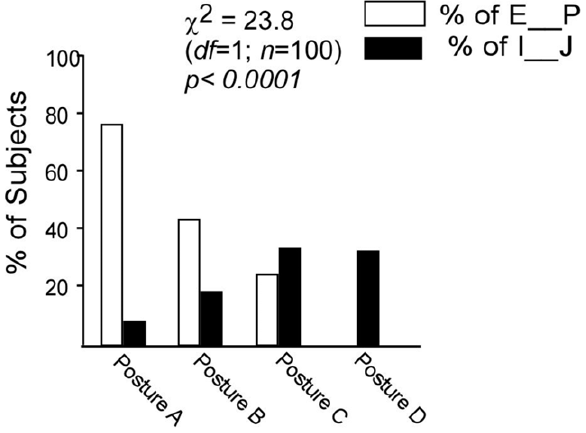
Figure 3. Graph of Adaptable Extraverts and Decisive Intro- verts. Further analysis indicated that there is a relationship between posture and the Adaptable Extraverts: ESTP, ESFP, ENFP, ENTP (E_ _P) as well as the Decisive Introverts: ISTJ, ISFJ, INFJ, INTJ (I_ _J) ( Extraversion- Introversion (E-I), Sensing-Intuition (S-N), Thinking-Feeling (T-F), and Judging- Perceiving (J-P) [ 16 ] . Sensing-Intuition (S-N) and Thinking-Feeling (T-F) describe mental functions and reflect basic preferences for use of perception and judgment, whereas Extraversion-Introversion (E-I) and Judging- Perceiving (J-P) reflect attitudes or orientations ).